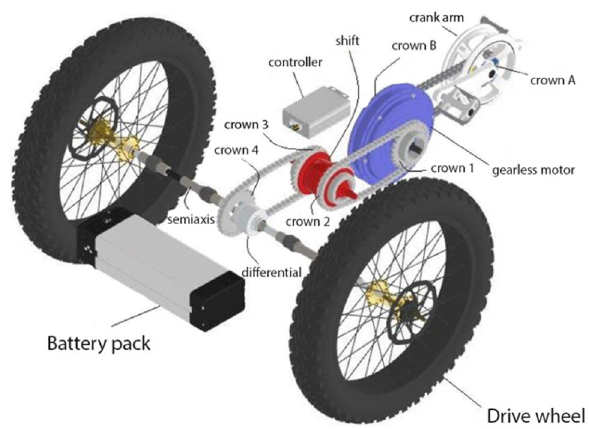
Fig. 7 Gearless type powertrain